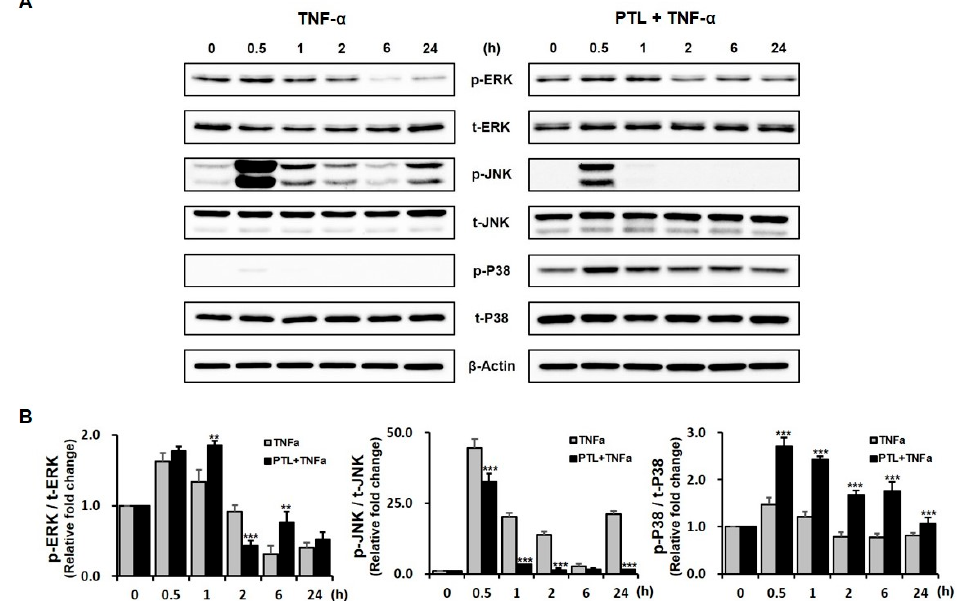
Figure 5. Effects of PTL on TNF- α -induced MAPK activation in hPDCs. TNF- α stimulated the phosphorylation of ERK and JNK in hPDCs, whereas pretreatment with PTL enhanced ERK and p38 phosphorylation in TNF- α -treated hPDCs. The effects of PTL on JNK phosphorylation were transient, at 0.5 h, in the TNF- α -treated hPDCs ( A ). The quantification of the Western blot was performed to determine the relative phosphorylation ratio of the MAPK pathway in hPDCs, which showed that the relative phosphorylation ratio of JNK was significantly decreased in TNF- α -treated hPDCs pretreated with PTL, whereas the relative phosphorylation ratio of p38 MAPK increased in cells pretreated with PTL. The phosphorylation of ERK significantly increased after 1 and 6 h, although it decreased at 2 h following pretreatment with PTL ( B ) ** p < 0.01, *** p < 0.001.